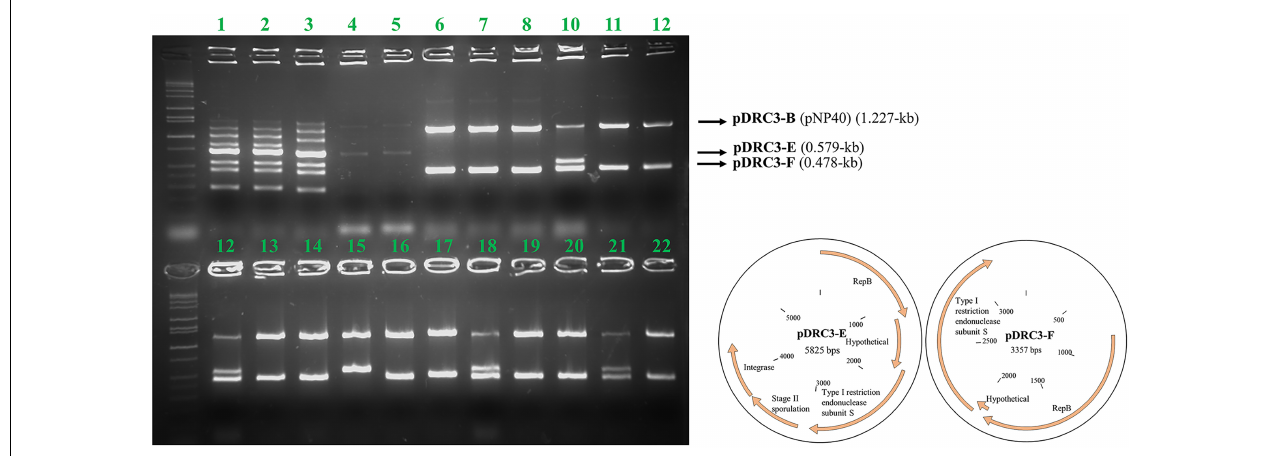
FIGURE 4 | Agarose gel electrophoresis results using Multiplex PCR. For every lane, all eight primers designed for this purpose were used. Lanes 1–3 correspond to the donor (DRC3), for which PCR products representing all plasmids can be observed: pDRC3-A (1,483 bps product size), pDRC3-B (1,227 bps), pDRC3-C (1,000 bps), DRC3 chromosome (852 bps), pDRC3-D (723 bps), pDRC3-E (579 bps), pDRC3-F (478 bps), and pDRC3-G (306 bps). Lanes 4–5 correspond to the recipient (MG1614), while lanes 6–22 are representative of randomly selected transconjugants. Plasmid DRC3-B (pNP40) was transferred in all cases, whereas plasmid DRC3-E was co-transferred in ∼ 30% of the colonies screened and plasmid DRC3-F was co-transferred in all but one case. A plasmid map of the co-transferred plasmids is also presented.